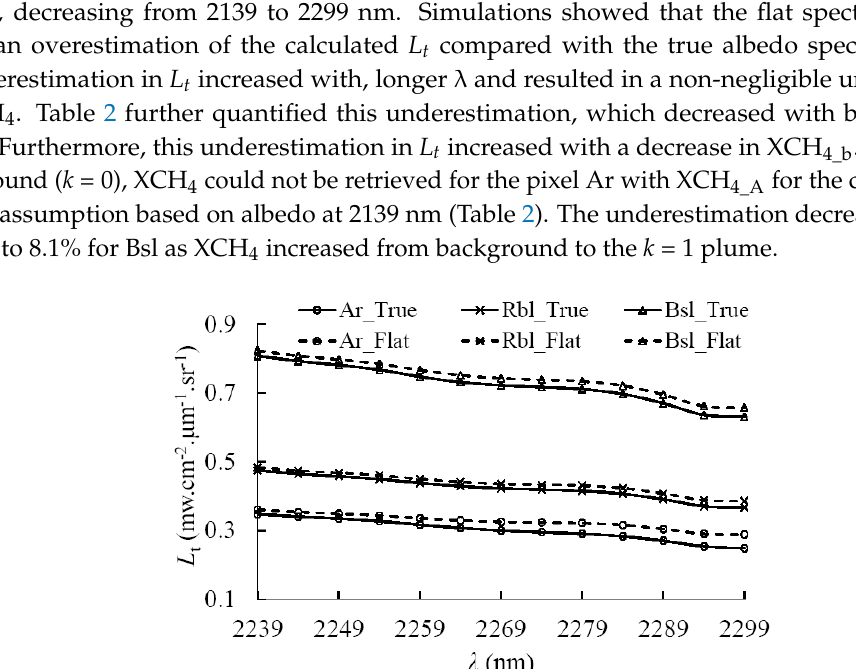
Figure 11. Calculated sensor radiance ( L t ) with respect to wavelength ( λ )simulated for background XCH 4 . Solid lines show L t for the true ρ s ( λ ) (denoted “_True”) for spectra for scene elements Asphalt